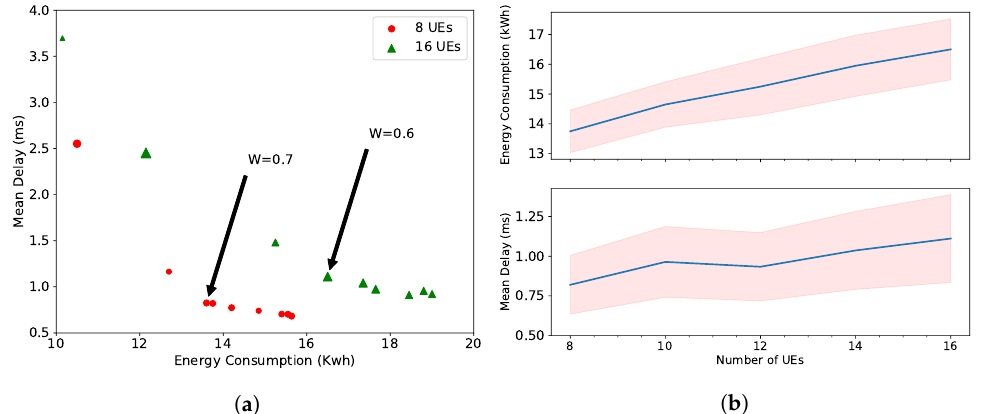
Figure 4. Energy consumption and mean delay performance with MILP solver: ( a ) the tradeoff between these two KPIs; ( b ) impact of increasing number of UEs.